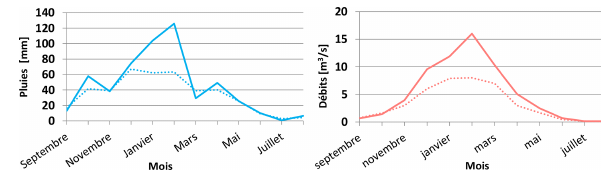
Figure 4. Évolution des pluies et débits mensuels sur le bassin du Bouregreg entre 1977 et 1997 (trait plein) et 1980 à 2013 (tireté) de septembre à